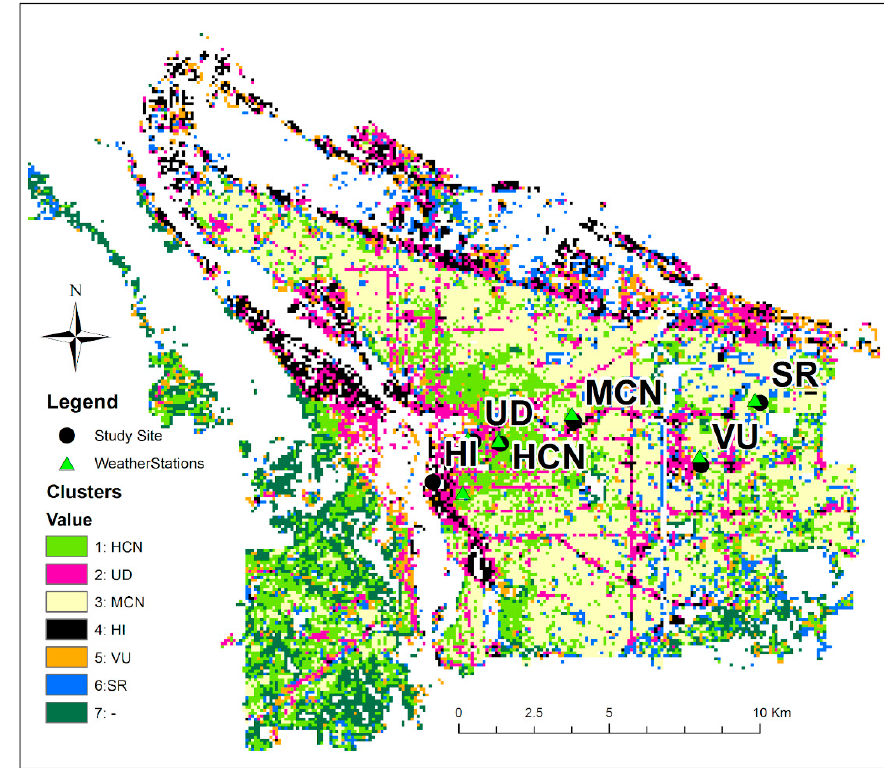
Figure 3. Locations of the seven clusters (as identified in Table 1), the six study sites that were ultimately selected for analysis, and the sites of the weather stations. No site was chosen for cluster 7, hillside forest, since no such area met the selection criteria.